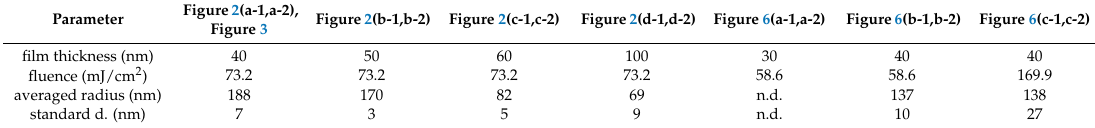
Figure 2d ‐ 1, 2d ‐ 2